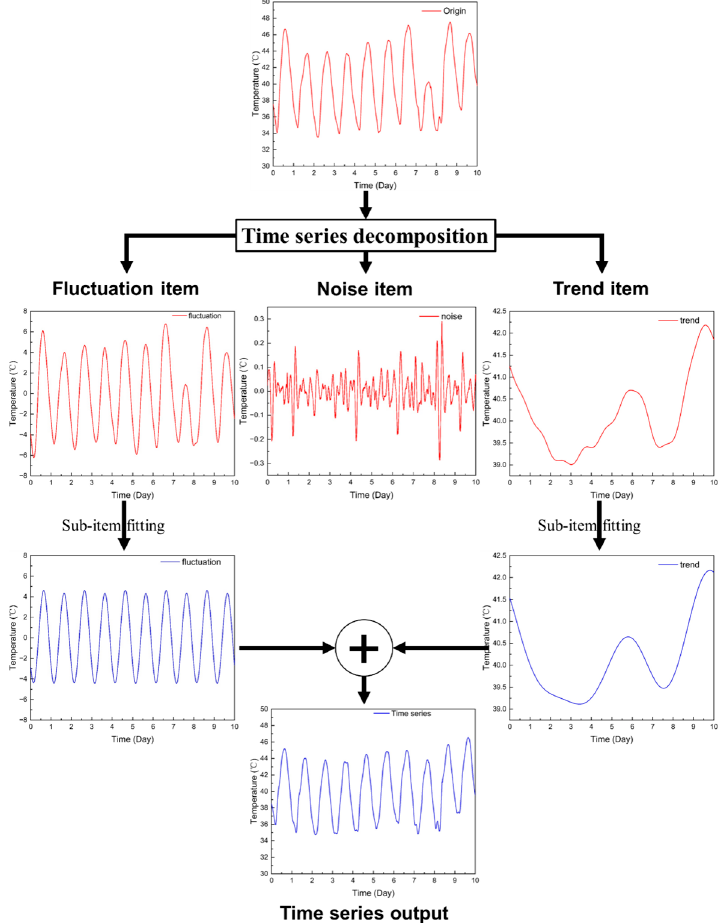
Figure 12. The mean absolute error was 0.978 °C , the maximum absolute error was 4.564 °C , and the mean relative error was 2.348%. Figure 10. Time series decomposition results. Figure 10. Time series decomposition results.